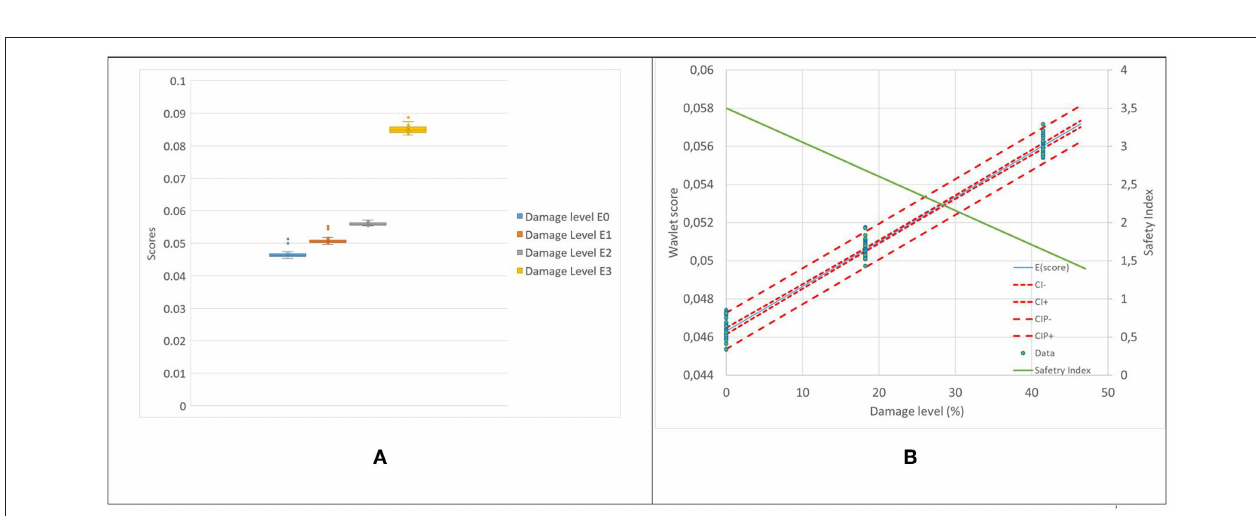
FIGURE 9 | Damage located at 0.17L. (A) Whisker plot of the scores of first component of wavelet coefficients at 4 damage levels, (B) Linear regression of scores as a function of damage level (Damage levels E 0 , E 1 , and E 2 ).